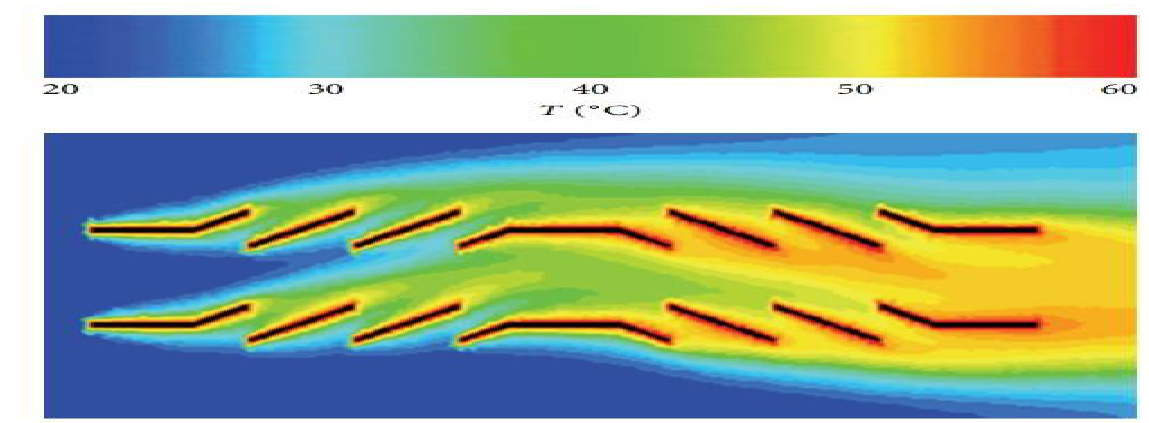
Figure 19: Temperature delivery along the flow direction for identical louver angle (20 ◦ ) with fin pitch of 1 mm (case A) and Re = 500 [30].